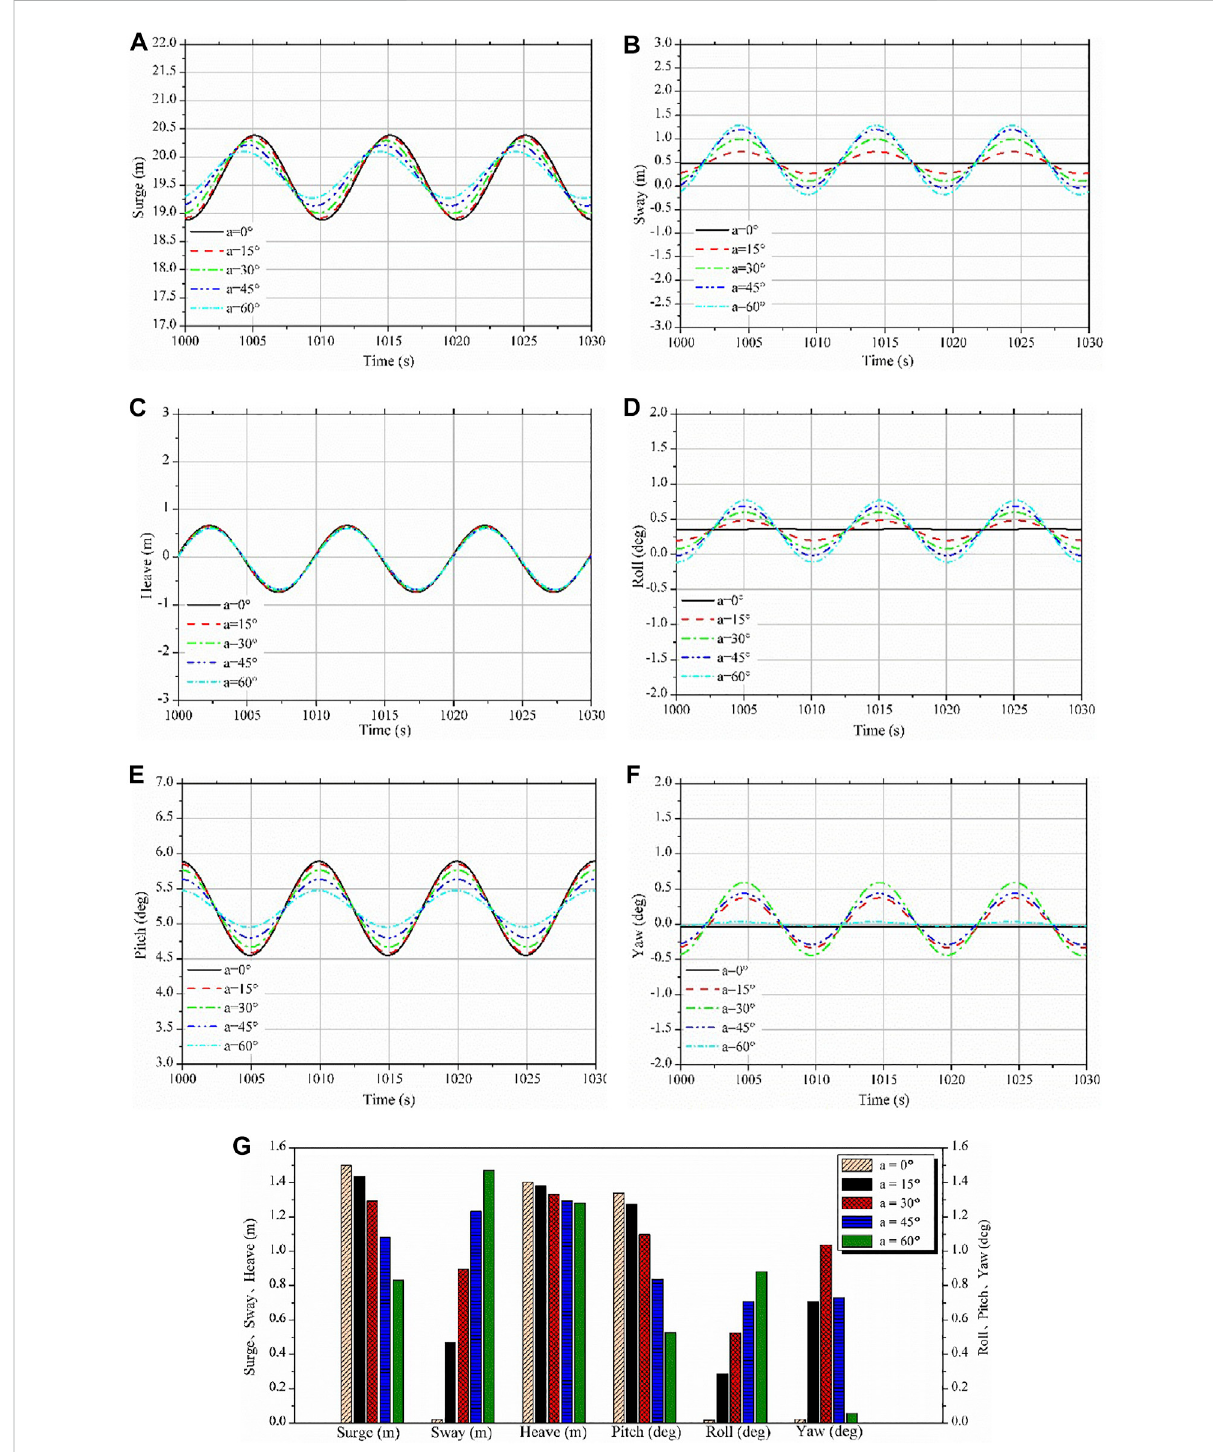
FIGURE 11 Motions of fl oating platform under different wave incidence angles: (A) Surge; (B) Sway; (C) Heave; (D) Roll; (E) pitch; (F) Yaw; (G) Motion